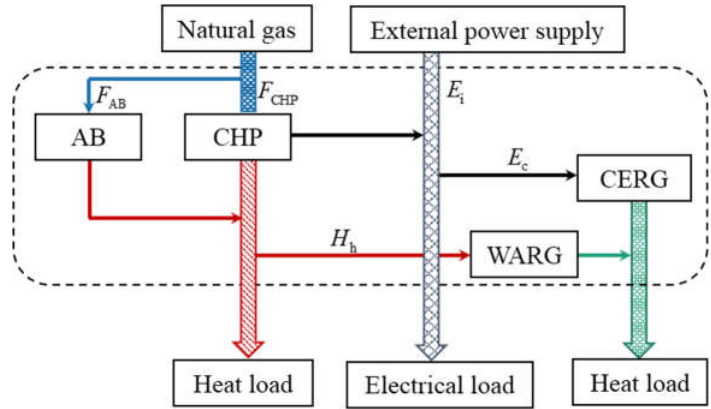
Figure 11. A typical regional cooling, heat, and electricity triple supply system.